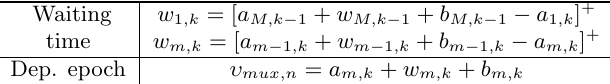
Table 3: FDES equations for the round-robin Mul- tiplexer